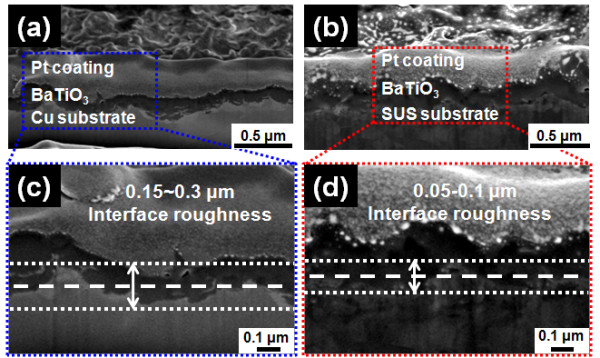
Cross-sectional SEM micrographs of 0.2-μm-thick BaTiO3thin films on (a) Cu and (b) SUS substrates. Enlarged cross-sectional SEM micrographs of the films on (c) Cu and (d) SUS substrates.